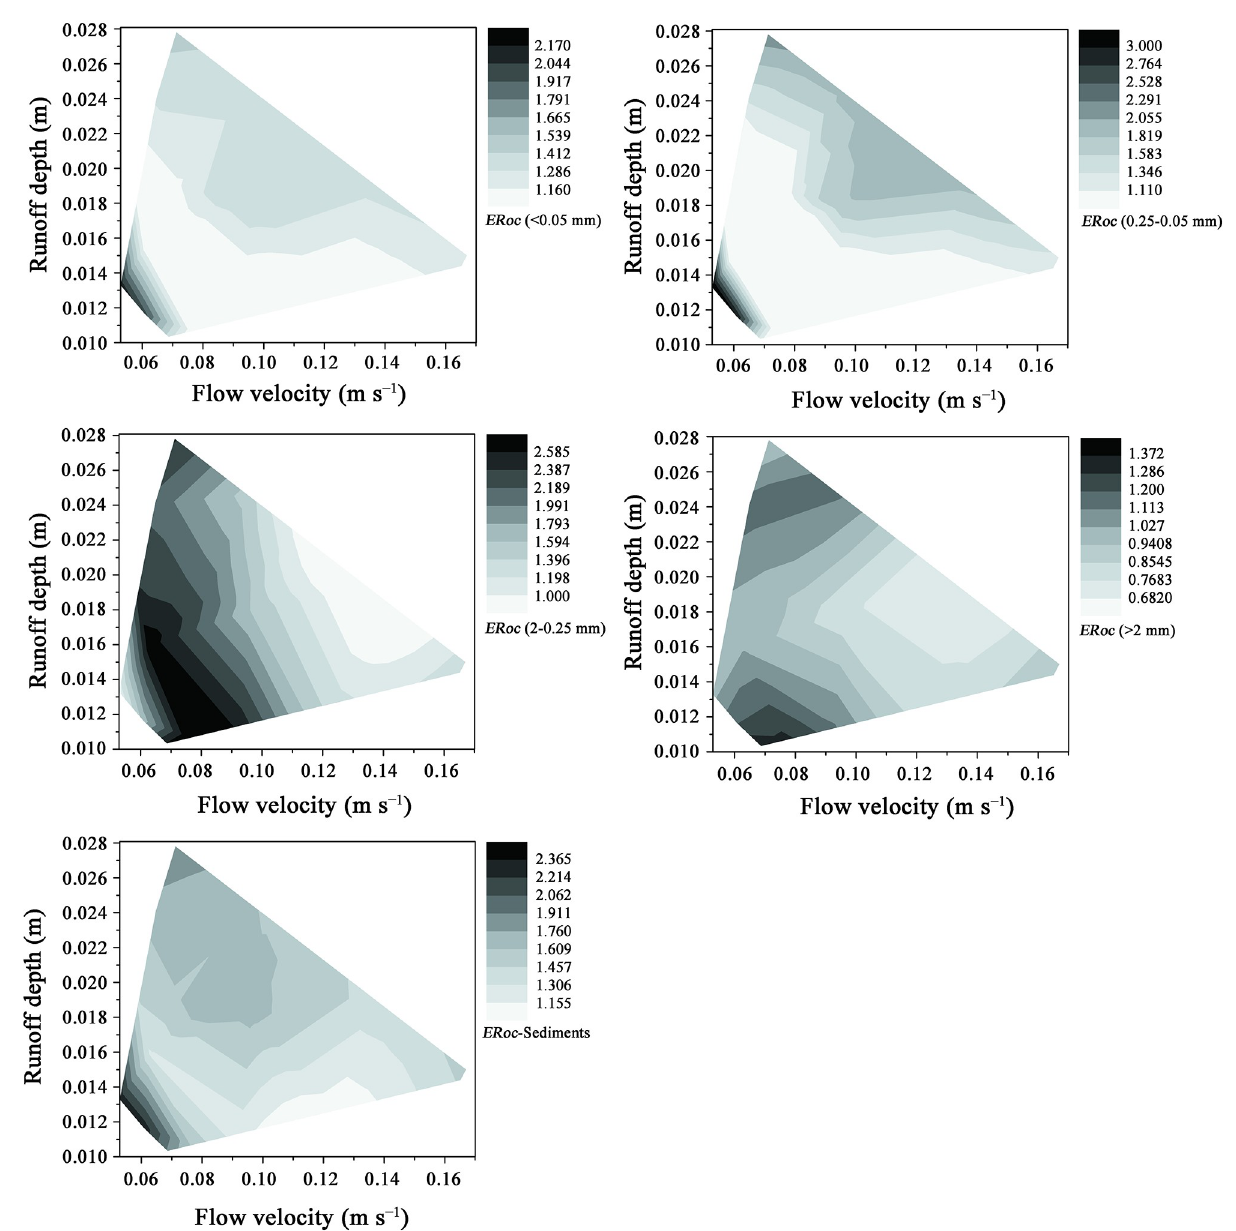
Fig 5. Effects of runoff depth–flow velocity interaction on ER OC (OC enrichment ratios) of silt with clay-sized particles ( ER oc ( < 0.05 mm)), coarse silt ( ER (0.25–0.05 mm)), fine sand ( ER oc